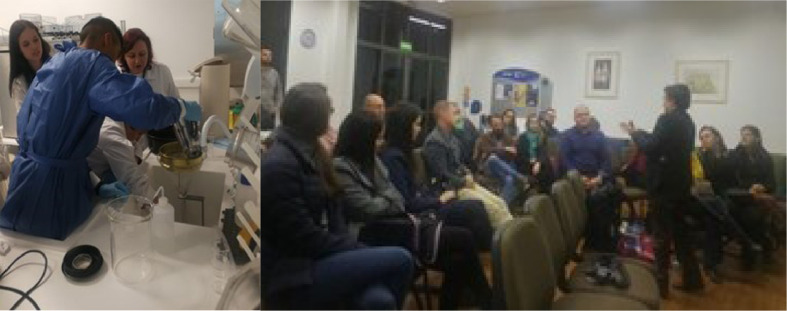
ISAE Laboratory.